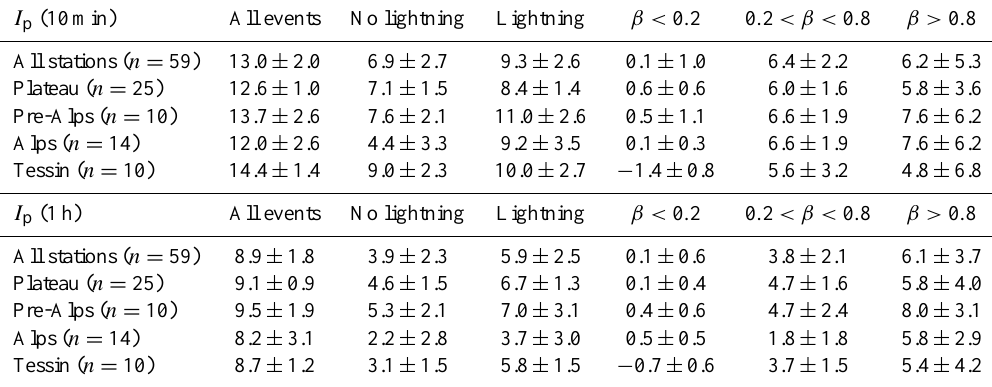
Table 2. Means of the regression slopes in % ◦ C − 1 fitted to the 95th percentile by quantile regression ± 1 standard deviation. Slopes are reported for peak I p event intensity for 10min and 1h time resolutions for all events, no-lightning events, lightning events, and storms grouped by the convectivity index β